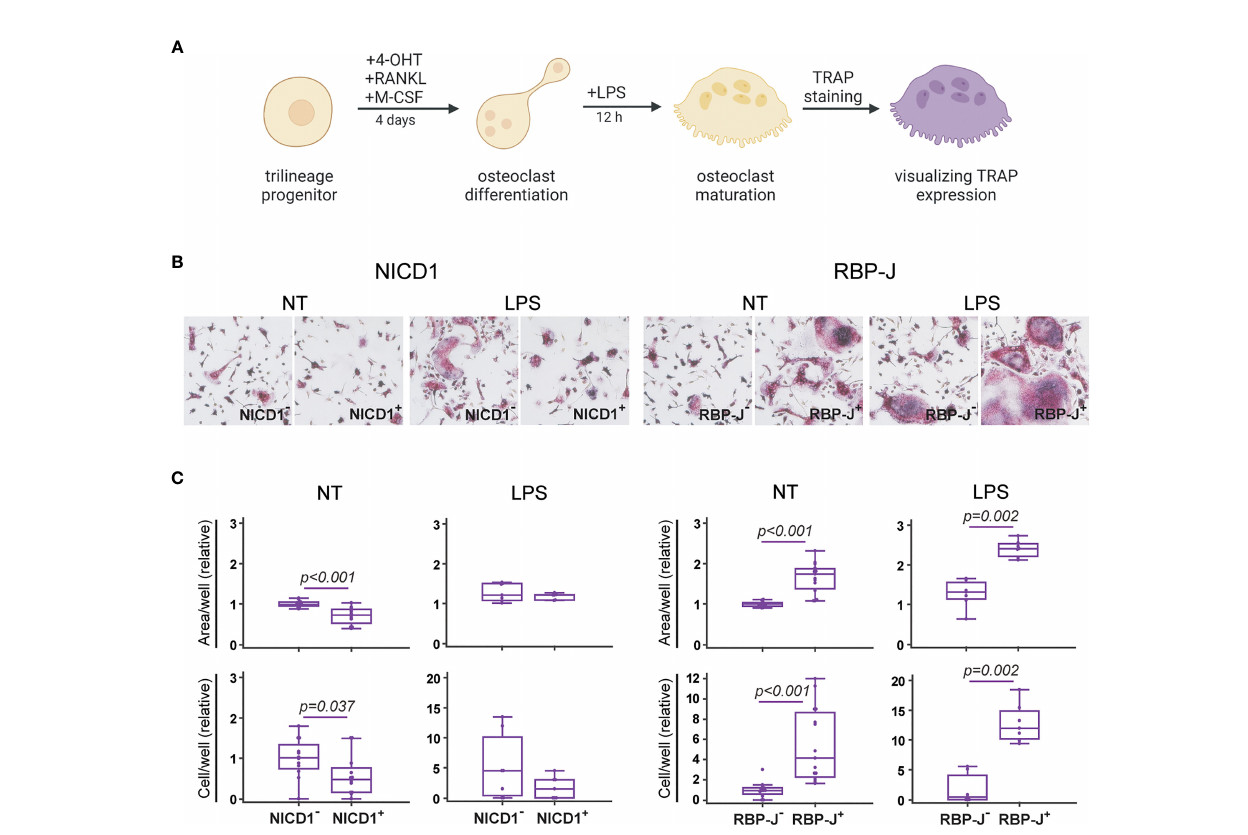
FIGURE 5 | Functional characterization of osteoclasts differentiated from the common trilineage progenitor (TLP) isolated from bone marrow cells of CX3CR1CreERT2/NICD1 (NICD1) and CX3CR1CreERT2/RBP-J (RBP-J) mice. Bone marrow cells were fl ushed from hind limb long bones and the common TLPs (A) Experimental design of osteoclast differentiation and functional testing. Osteoclast differentiation was induced by the addition of receptor activator of nuclear factor k B ligand (RANKL) and macrophage colony-stimulating factor (M-CSF). Cre-mediated recombination in Cre + (NICD1 + or RBP-J + ) littermates was induced by the addition of 4-hydroxytamoxifen (4-OHT). Cre − (NICD1 − or RBP-J − ) littermates treated with 4-OHT were used as controls. Lipopolysaccharides from E.coli (LPS) were added 12h before fi xation to induce the in fl ammatory response. Expression of tartrate-resistant acid phosphatase (TRAP) in multinucleated cells was used as a functional assay. Created with BioRender.com (B) Representative images of culture wells with TRAP + multinucleated osteoclasts differentiated from TLP under LPS stimulation. TRAP + multinucleated cells with more than three nuclei and of diameter greater than 125 µm were counted as large osteoclasts (magni fi cation 100×). (C) Quanti fi cation of multinucleated TRAP + osteoclasts differentiated from TLP under LPS stimulation. Number and area of large multinucleated TRAP + osteoclasts were normalized to the value of Cre − controls without LPS stimulation. Pooled data from three independent experiments are shown (n=7-12). Individual values are presented; horizontal lines represent the median, boxes represent the interquartile range (IQR), whiskers represent 1.5 times the IQR. Statistically signi fi cant difference was determined at p<0.05, Mann – Whitney